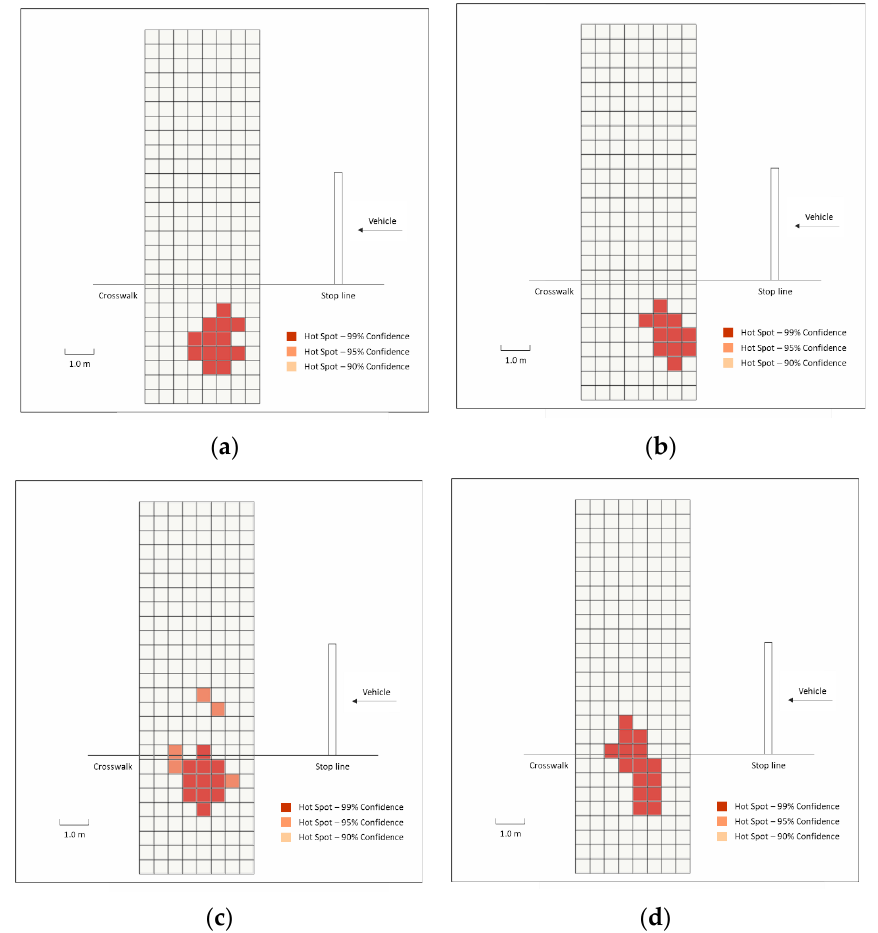
Figure 8. Hot spot analysis of pedestrian’s position in Group 2a (high perceived safety) and Group 2b (low perceived safety). ( a ) Group 2a at − 7.0 s. ( b ) Group 2b at − 7.0 s. ( c ) Group 2a at 0 s. ( d ) Group 2b at 0 s.